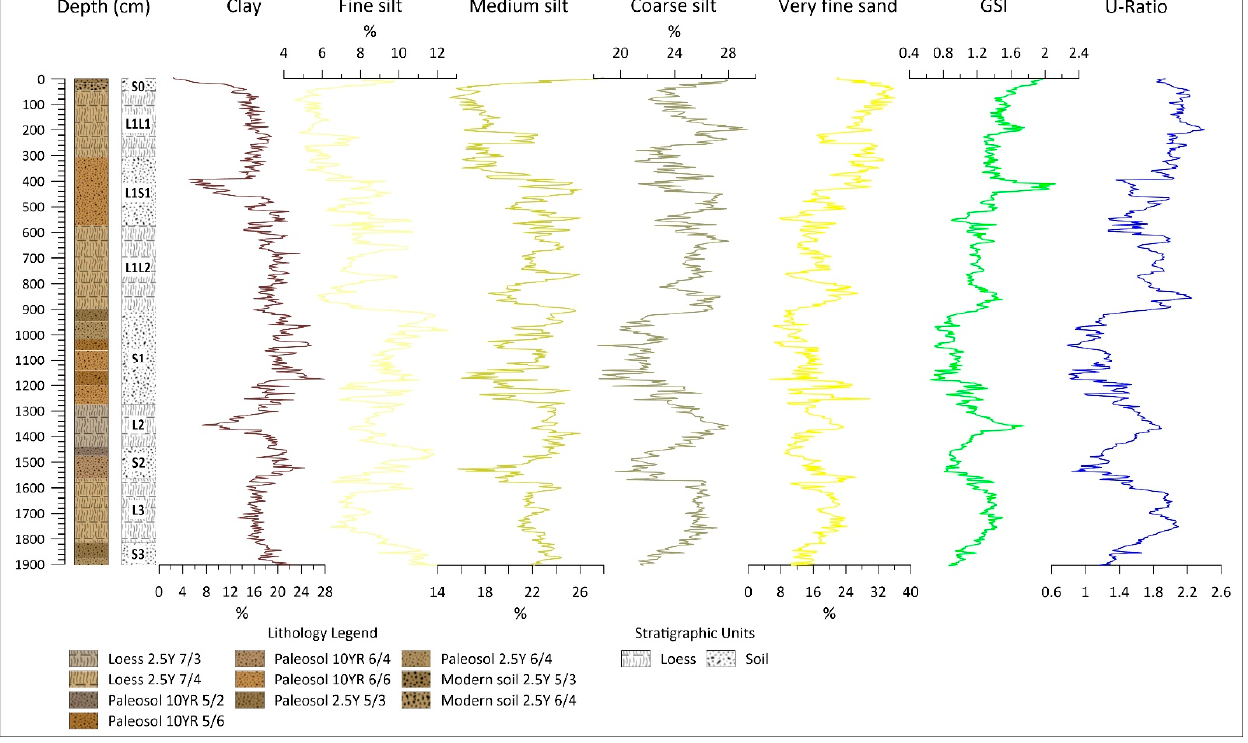
Figure 2. Grain size compositions plotted on separated line diagrams, GSI and U-ratio line diagrams [12,14,15,19,22,26–29].